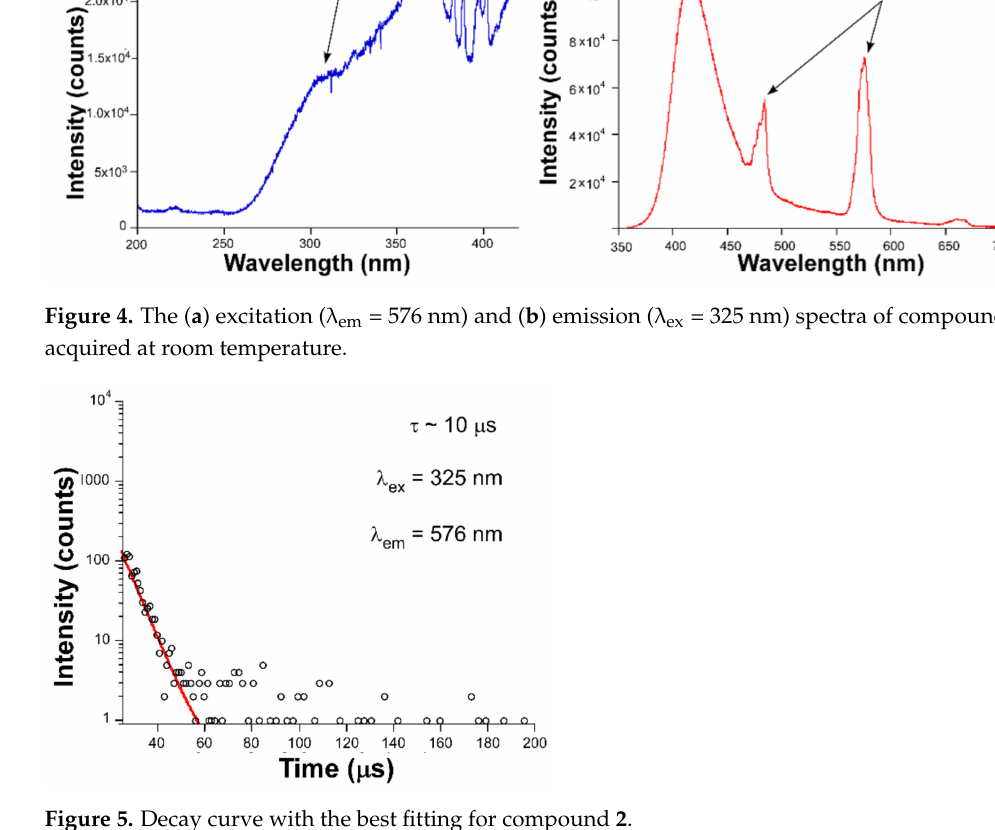
Figure 5. Decay curve with the best fitting for compound 2